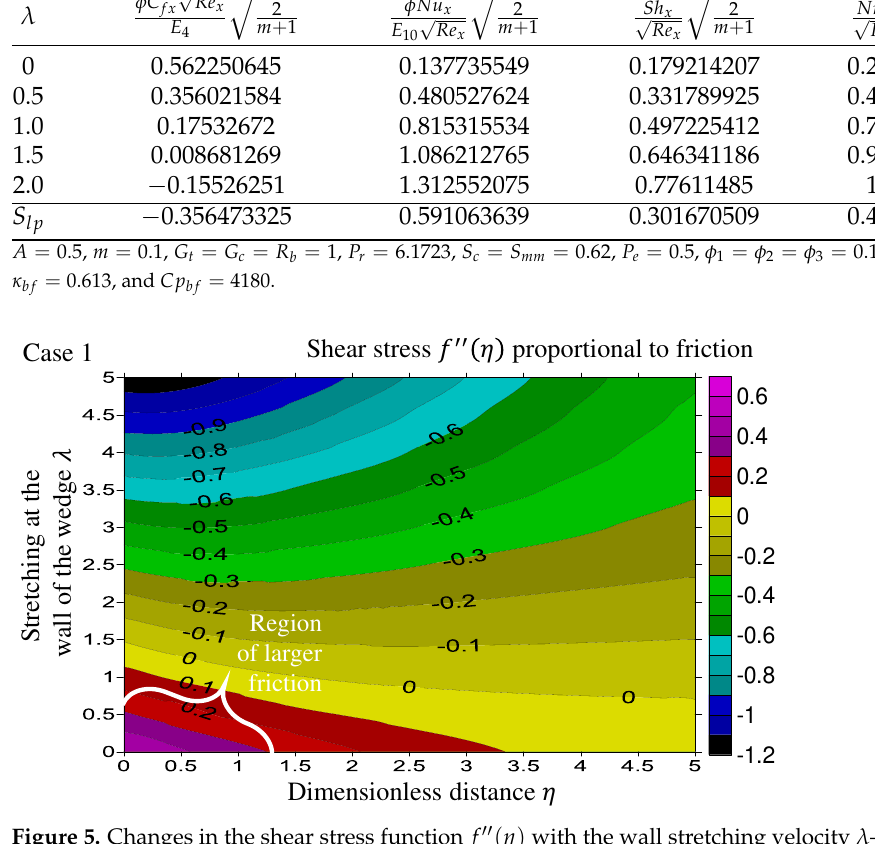
Figure 5. Changes in the shear stress function f (cid:48)(cid:48) ( η ) with the wall stretching velocity λ —case 1.